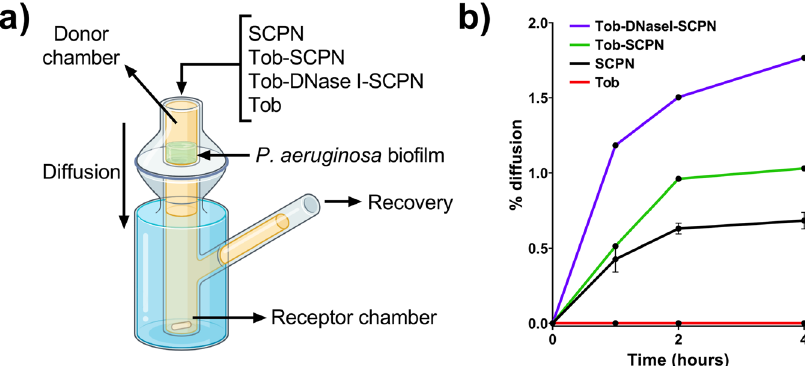
Fig. 3 Permeability assay of SCPN diffusion into the P. aeruginosa bio fi lm. a Scheme of the Franz cell. b % diffusion of different SCPNs: SCPN (without tobramycin and DNase I) (black line), Tob-SCPN (green line), Tob-DNase I-SCPN (purple line), and free tobramycin (Tob, red line). Error bars indicate the standard deviation between three replicates of two different